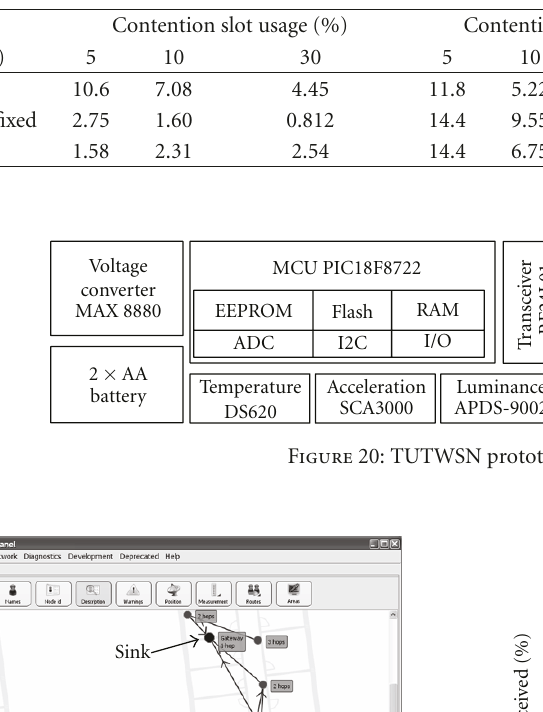
Table 7: Average contention and contention-free slot usages and end-to-end latencies.